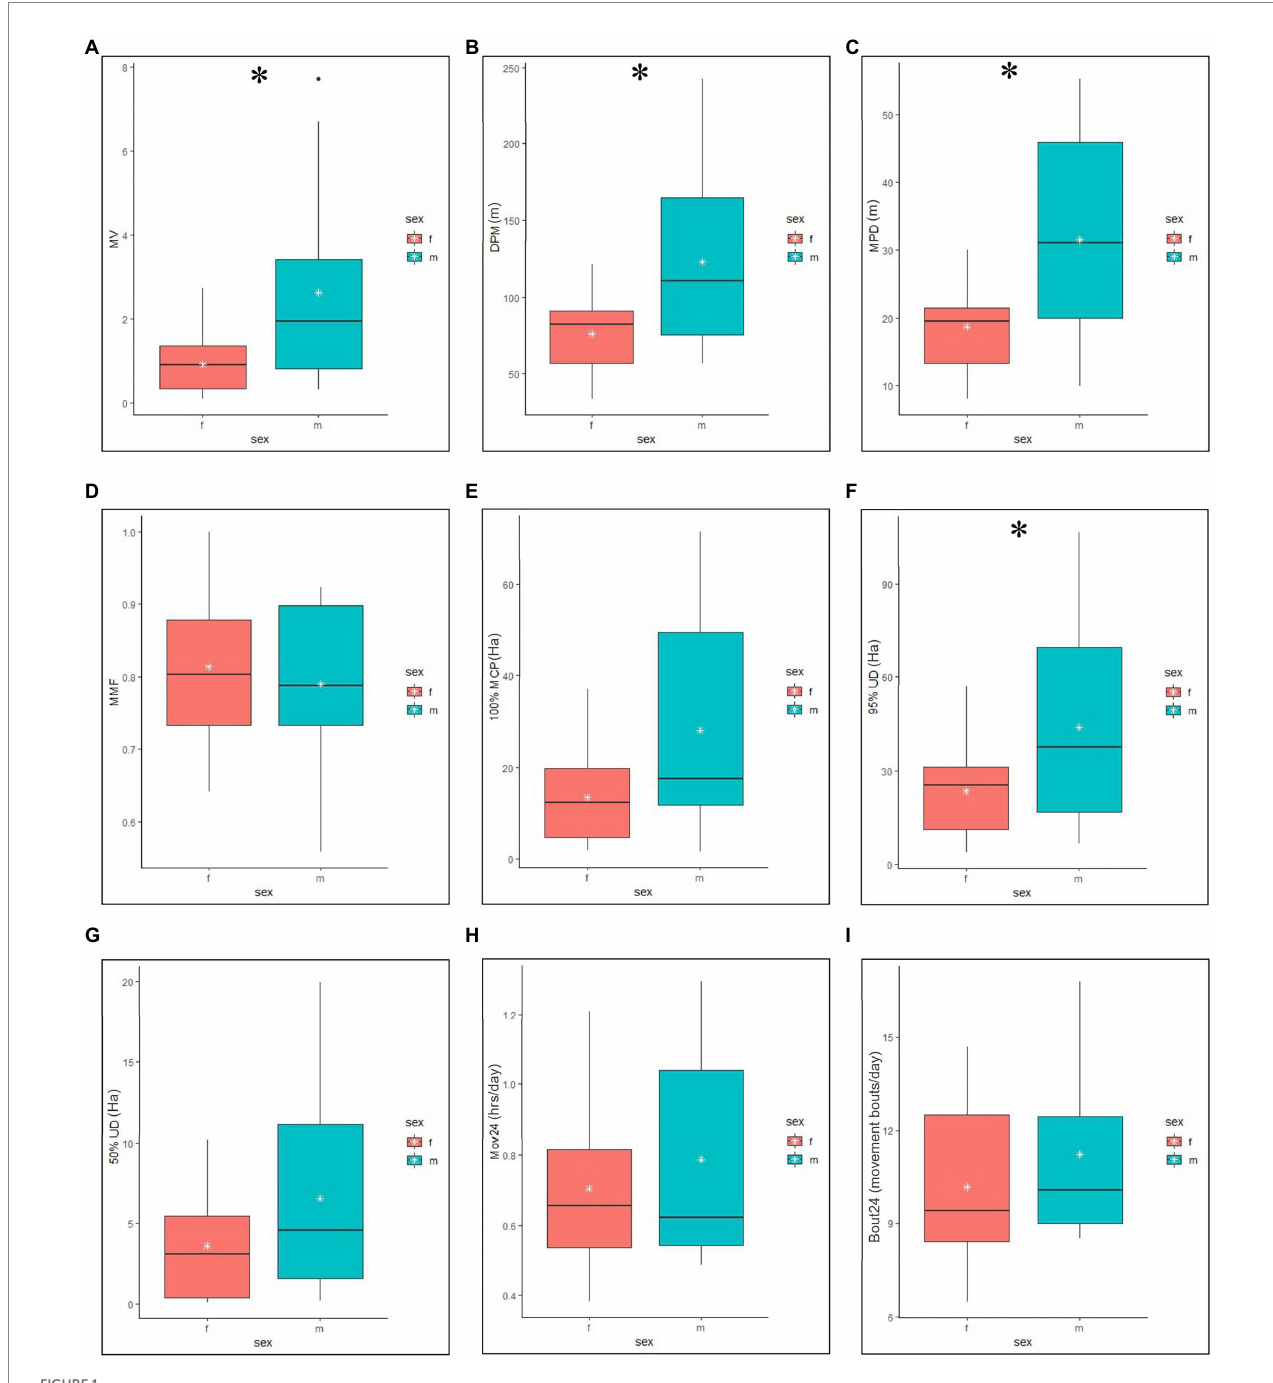
FIGURE 1 Annual minimum, median, mean (white stars), and maximum values, and the interquartile ranges of male and female Crotalus horridus RT and ACT metrics. RT derived movement measures (A–D) include Motion Variance (MV), Distance Per Movement (DPM), Meters Per Day (MPD), and Minimum Movement Frequency (MMF). RT derived space use measures (E–G) include 100% Minimum Convex Polygons home range (MCP), 95% fixed kernel Utilization Distribution home range (95% UD) and 50% fixed kernel Utilization Distribution core use area (50% UD). ACT derived movement measures (H,I) include the mean time spent moving per 24 h (Mov24) and the mean number of movement bouts per 24 h (Bout24). Asterisks denote significant differences ( p <